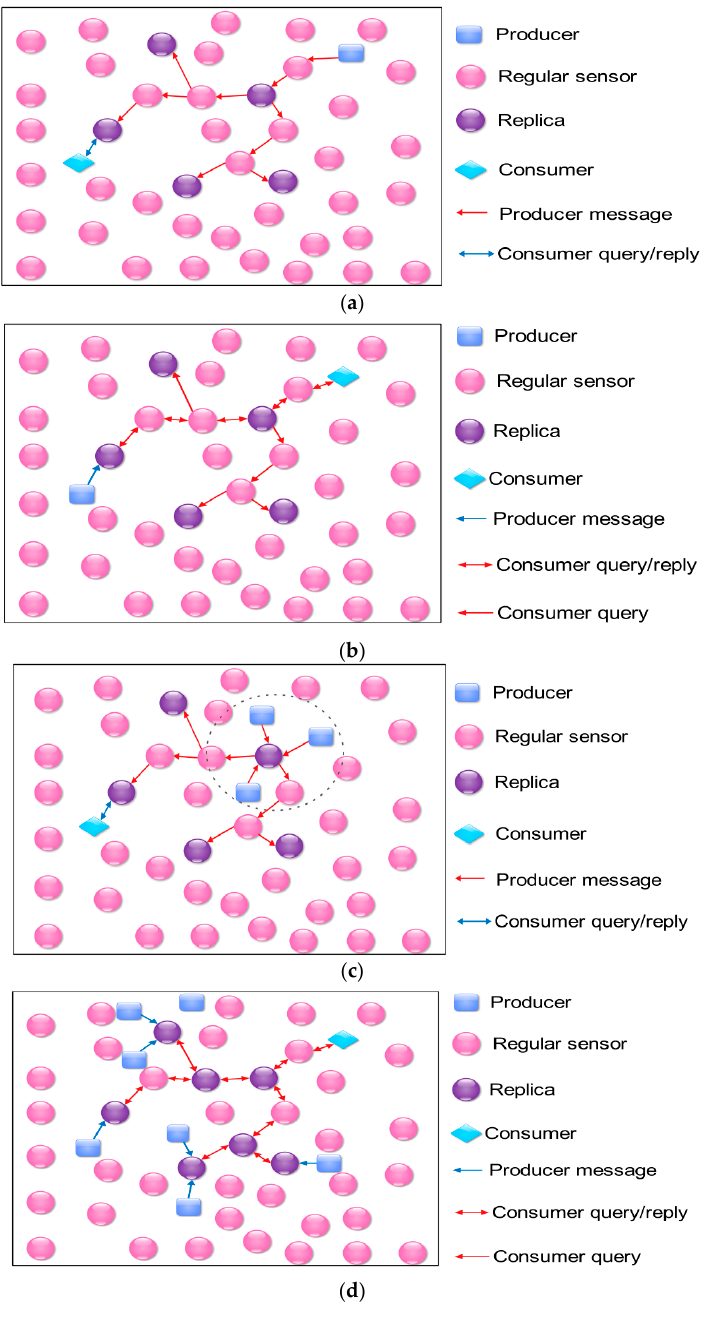
Figure 1. Data storage and information discovery in the four application profiles: ( a ) consumption traffic dominates production traffic with no data aggregation; ( b ) production traffic dominates consumption traffic with no data aggregation; ( c ) consumption traffic dominates production traffic with data aggregation; ( d ) production traffic dominates consumption traffic with data